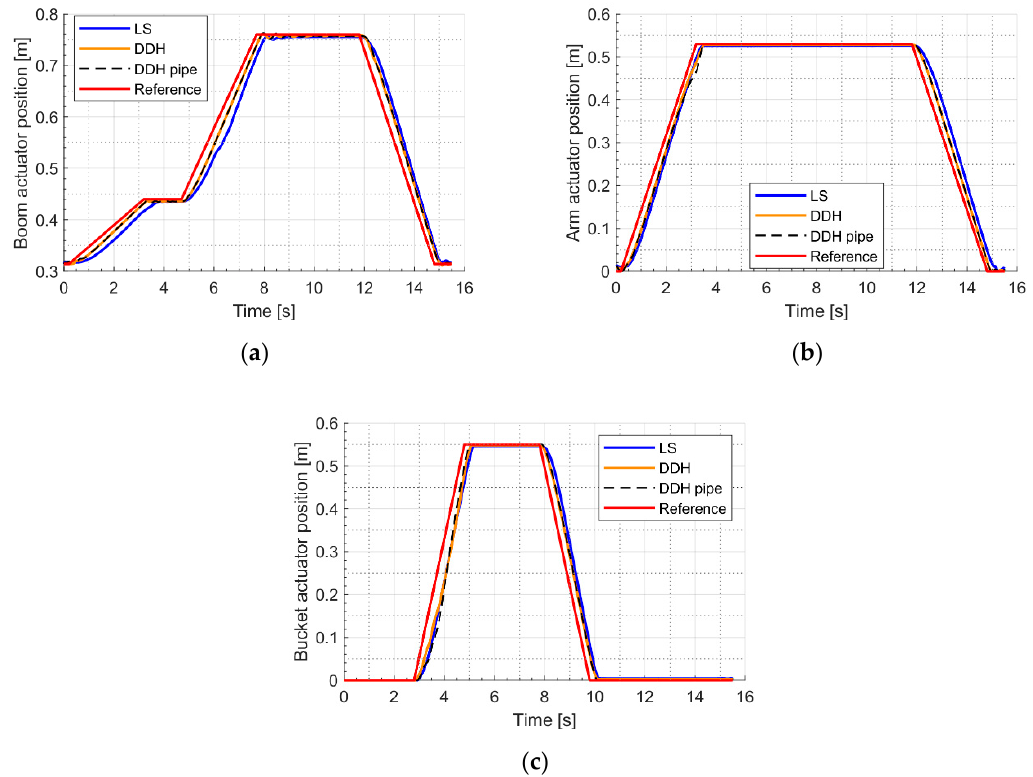
Figure 7. Actuator response to reference position of duty digging cycle: simulations results ( a ) boom, ( b ) arm, ( c ) bucket.